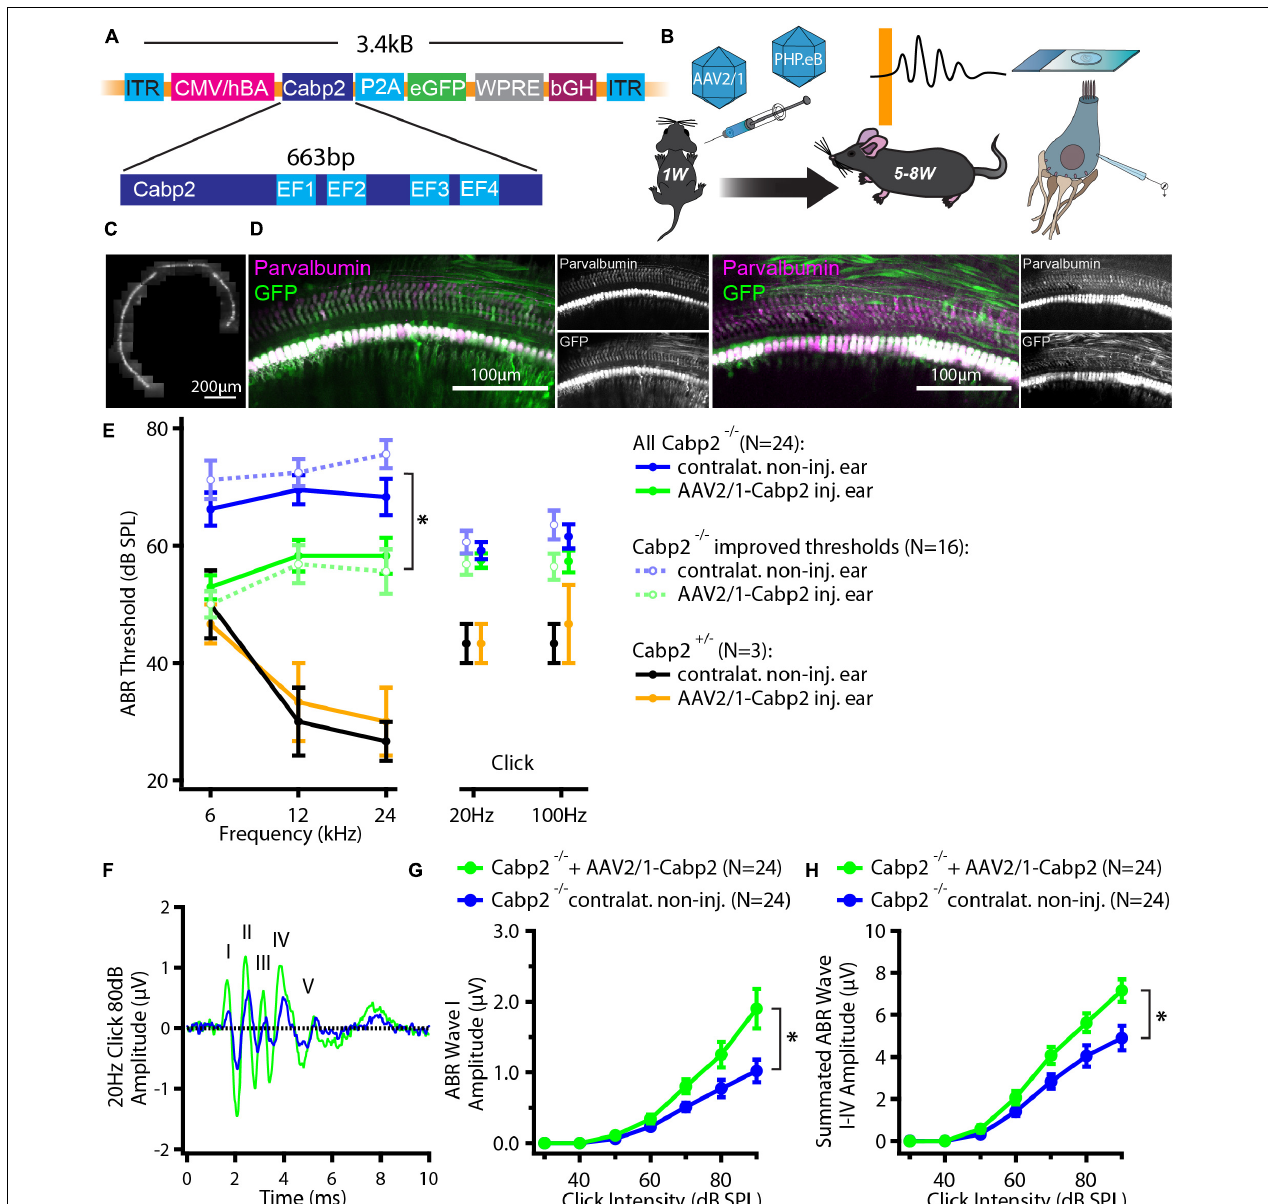
FIGURE 1 | Experimental design and hearing improvement in calcium-binding protein 2 ( Cabp2 ) - / - animals injected with AAV2/1- Cabp2 . (A) Schematic representation of the plasmid construct: An hCMV enhanced hBA promotor with the WPRE enhancer drives the expression of Cabp2 and eGFP , which are separated by a self-cleaving P2A peptide. The construct was inserted in two viral vectors, AAV2/1 and synthetic AAV-PHP.eB. (B) Mice of either sex received virus injections at postnatal day P5-7 and were tested for hearing at 5–8 weeks of age. Afterward, cochleae were harvested for patch-clamp experiments or processed for immunohistochemistry. (C) Representative image of an apical coil of the organ of Corti from an animal injected with AAV2/1- Cabp2 - eGFP as observed under a fluorescent microscope. Several images were taken and stitched together to reconstruct the whole apical turn. A row of fluorescent IHCs can be observed, indicating high transduction efficiency of the virus. Please note that the fluorescence line of the IHCs is broken three times due to the nylon grid holding the explant in place. (D) Representative images of the midcochlear region of two AAV2/1- Cabp2 - eGFP injected cochleae immunolabeled for eGFP and a hair cell marker parvalbumin alpha. A row of transduced IHCs is clearly visible due to strong staining with both antibodies. (E) Average ABR thresholds for tone bursts and clicks. Contralateral non-injected ears of each animal served as controls. Out of all 24 injected animals (solid lines; asterisk: two-way RM ANOVA with Šidak’s multicomparisons test; p = 0.002, 0.01 and 0.03 for the 6, 12 and 24-kHz tone burst, respectively), 16 showed improved thresholds (dotted lines; two-way RM ANOVA with Šidak’s multicomparisons test; p < 0.0001 for all tone bursts). (F) Example ABR response to an 80-dB click stimulus (presented at 20 Hz repetition rate) from an injected (green) and the contralateral ear (blue) of the same animal. The ABR waves are marked with roman numbers. (G) ABR wave I amplitude in response to 20-Hz clicks of different intensities. (H) Summated amplitude of the first four ABR waves in response to 20-Hz clicks of different intensities. Note increased ABR amplitudes in injected Cabp2 - / - ears as compared to contralateral non-injected controls ( p < 0.001 and < 0.0001 in panel G and H, respectively; asterisks; two-way RM ANOVAs with Šidak’s multicomparisons tests). Asterisks denote p -values of less than 0.05.